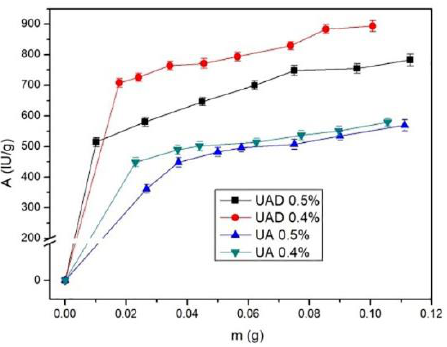
Figure 5. Effect of the biocatalysts mass on the activities of alcalase immobilized onto alginate submicron beads produced by ultrasonic atomization.